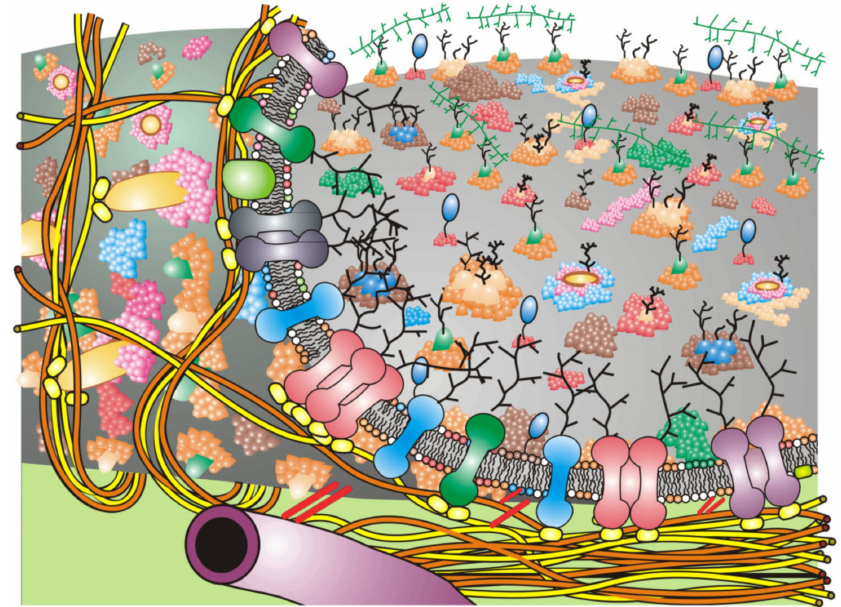
Figure 2. An updated, static representation of the Fluid–Mosaic Membrane Model with more detail than presented in the original 1972 Singer and Nicolson model [8]. The cell membrane of a generic tissue cell is depicted with various lipid and protein domain structures as well as membrane- associated cytoskeletal and extracellular structures. The cell membrane has been peeled back at the left in order to reveal underneath the plasma membrane. Membrane-associated cytoskeletal elements can be arranged to form potential barriers (‘corrals’) that could possibly limit the lateral mobilities of some of the integral transmembrane proteins. In addition, membrane-associated cytoskeletal structures can indirectly interact with some of the integral membrane proteins at the inner membrane surface along with stromal or extracellular matrix components at the outer surface. Although this static diagram presents some of the possible mechanisms of integral membrane protein mobility restraint, it does not accurately represent the dynamic changes in membrane components, the sizes and structures of phospholipids and lipid domains, integral and peripheral membrane proteins or membrane-associated cytoskeletal structures. It also does not reflect the actual crowding or high density of membrane components. (Modified from Nicolson